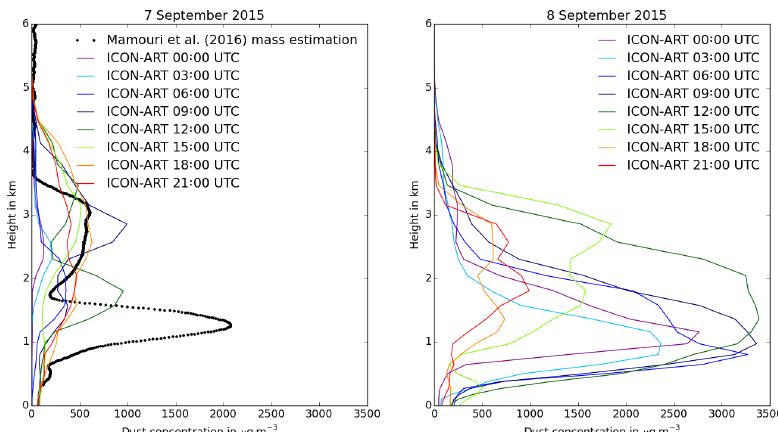
Figure A7. Mamouri et al. (2016) mass estimation from lidar observations for the EARLINET (European Aerosol Research Lidar Network) station in Limassol, Cyprus, for 19:00UTC, 7 September, and ICON-ART model results for 7 and 8 September at 34.7 ◦ N, 35.0 ◦ E. Please note the 2 ◦ eastward shift of the ICON-ART results shown compared to the Limassol observations due to the spatial offset of the dust plume; see Sect.